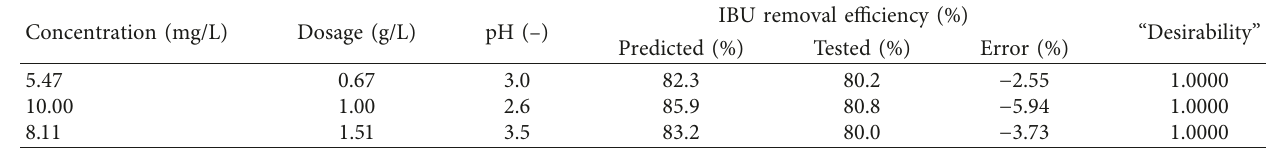
Table 5: Optimal conditions and confirmation runs.